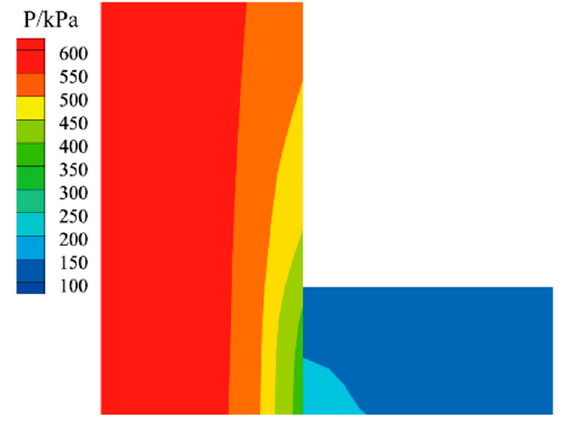
Figure 7. Fluid pressure distribution.